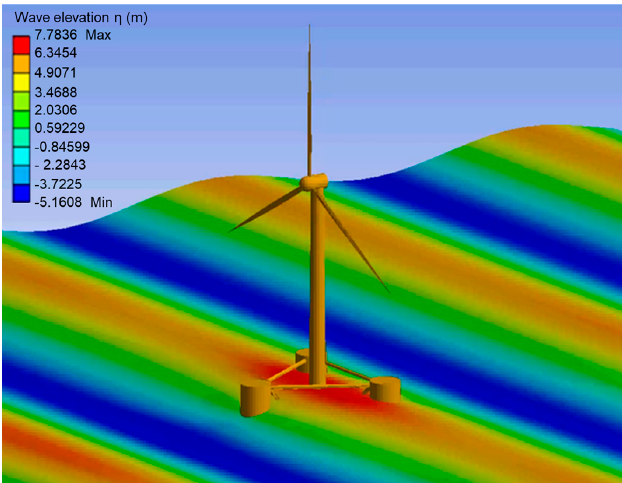
Figure 7. Visualization of the interaction between waves and DeepCwind semi-submersible FOWT.